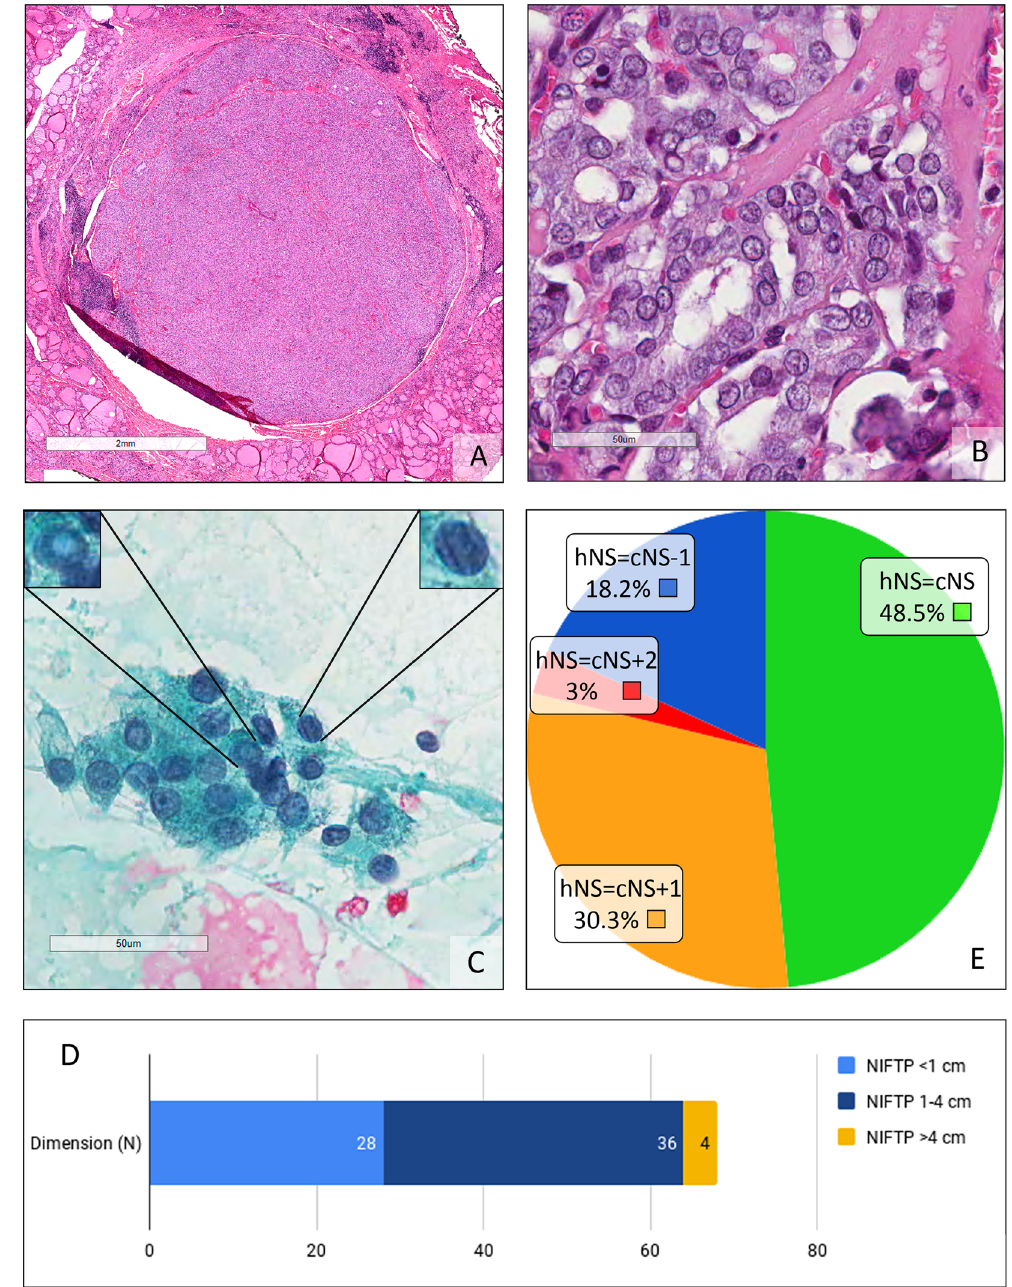
Figure 1. ( A ) Micro Noninvasive follicular thyroid neoplasm with papillary-like nuclear features (NIFTP). This incidental, 5 mm diameter lesion is completely encapsulated. (H&E, 2x). ( B ) Detail on cells of the micro Noninvasive follicular thyroid neoplasm with papillary-like nuclear features (NIFTP). Regarding size and shape, membrane irregularities and chromatin characteristics resulting in a NS of 3. (H&E, 40x). ( C ) Cytological smear of a Noninvasive follicular thyroid neoplasm with papillary-like nuclear features (NIFTP). On the left, magnification of a cell with a pseudoinclusion. On the right, magnification of a cell showing grooves. The final diagnostic class was THY4-suspicious of malignancy. (Papanicolau, 40x). ( D ) Distribution of the diameters in our Noninvasive follicular thyroid neoplasm with papillary-like nuclear features (NIFTP) case series. ( E ) Comparison between the cytological nuclear score (cNS) and histological nuclear score